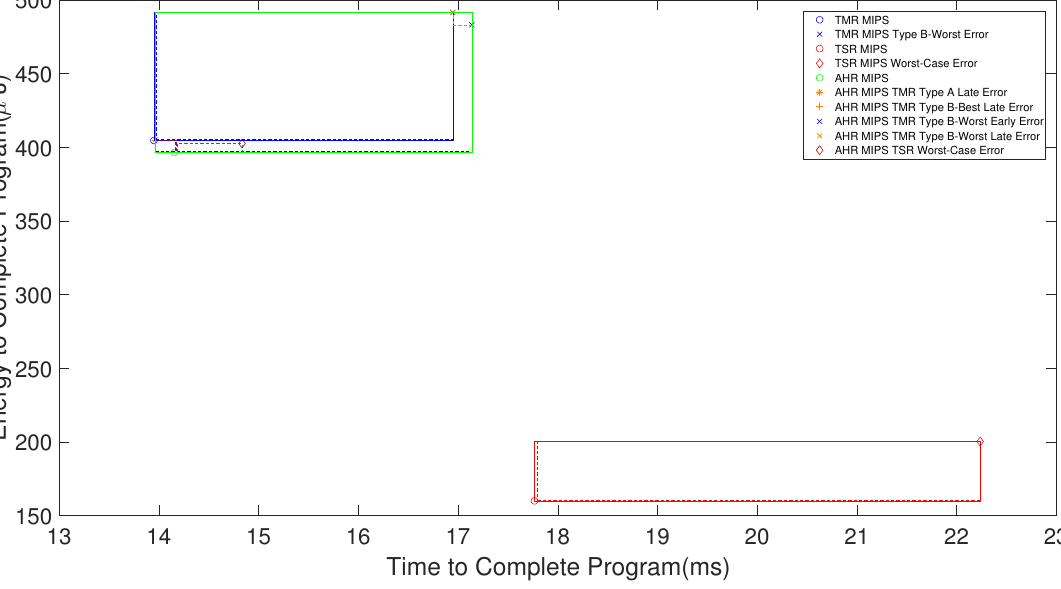
Figure 13. Average performance bounds for AHR MIPS with a TMR to TSR point at 60,000 instructions.